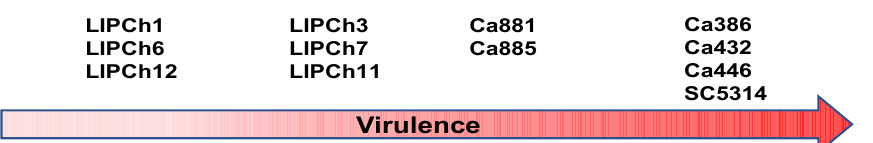
Figure 1. Survival curves of Galleria mellonella infected with 5 × 10 4 yeasts of ( A ) C. auris (Ca432; Ca386; Ca446; Ca881 and Ca885) or ( B ) C. haemulonii species complex (LIPCh1; LIPCh3; LIPCh6; LIPCh7; LIPCh11; LIPCh12). Survival was measured for 10 days. C. albicans SC5314 was used as control group; ( C ) statistical comparison of each survival curve and subsequently classification in 4 virulence groups. Data are representative of three independent experiments. Long-rank (Mantel–Cox) test, p < 0.05. * p < 0.02, ** p < 0.001, *** p < 0.0005 and p **** p < 0.0001.